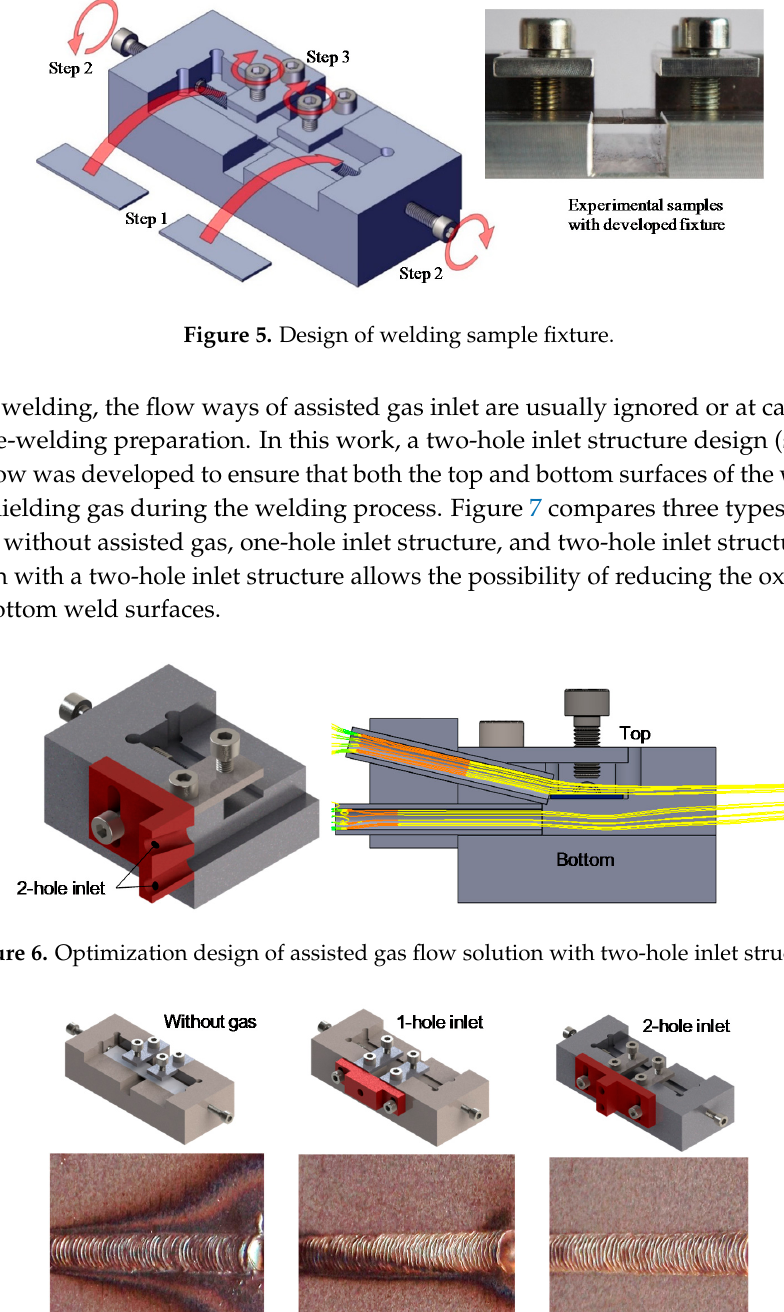
Figure 7. Comparison of welding top surface quality with different assisted gas inlet structures.